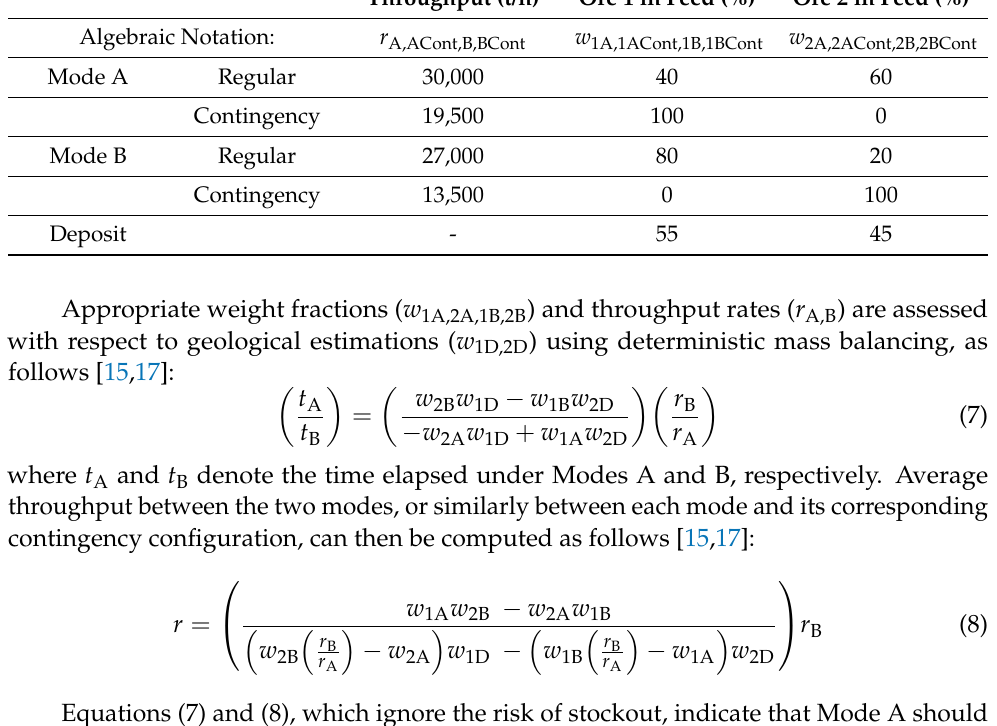
Table 5. Description of operational modes in relation to deposit forecast. Throughput (t/h) Ore 1 in Feed